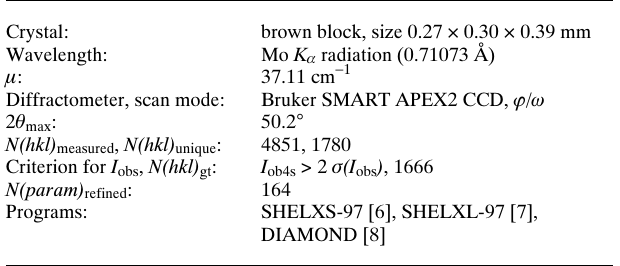
Table 1. Data collection and